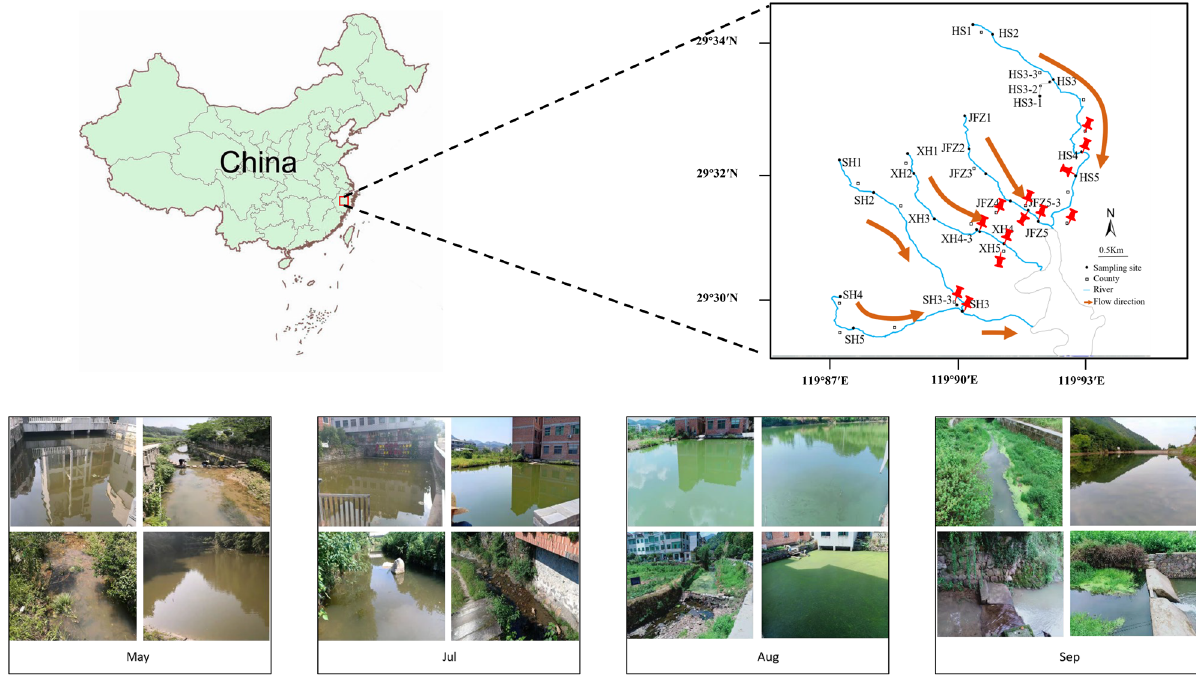
Figure 1. Diagram of Yankou Reservoir Basin indicating the sampling points on each river. The sampling sites were located using the global positioning system (GPS) and were nominated after the names of corresponding rivers. Map was created with ArcGIS software (V10.6, https:// deskt op. arcgis. com/ zh- cn/ deskt op/). Field photos were taken at each sampling point (pins only indicated some of the locations for concise presentation), and representative ones were selected to show the bloom course from May to